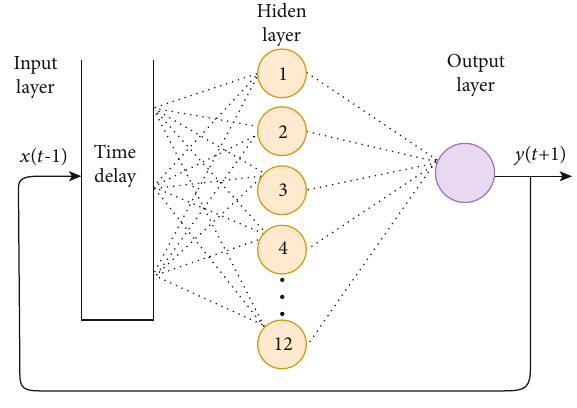
Figure 2: Computation of the NARNET model. Table 4: Parameters of the developed ANN (NARNET)